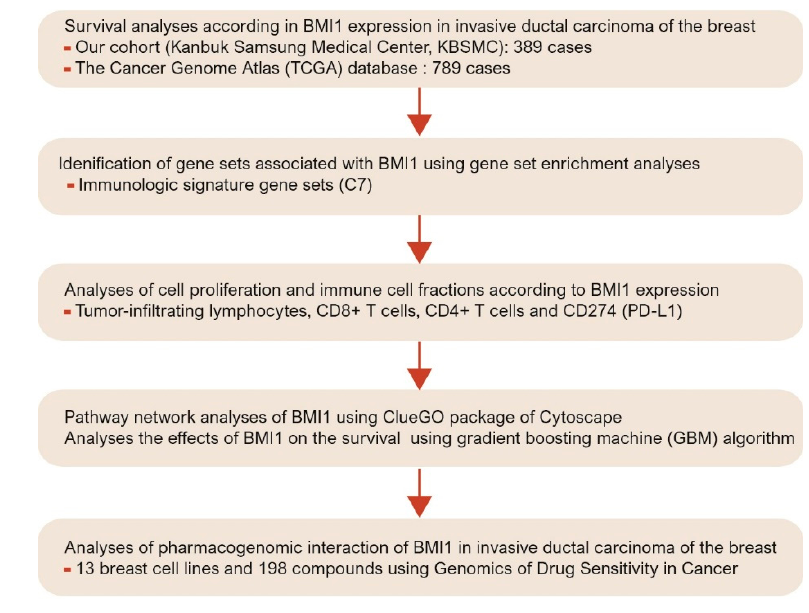
Figure 1. A schematic diagram depicting the analysis pipeline of this study.